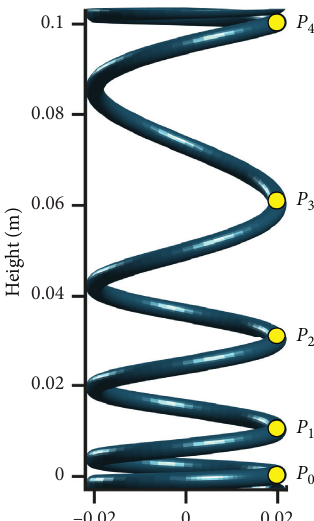
Figure 4: Model of a spring with variable pitches in the initial